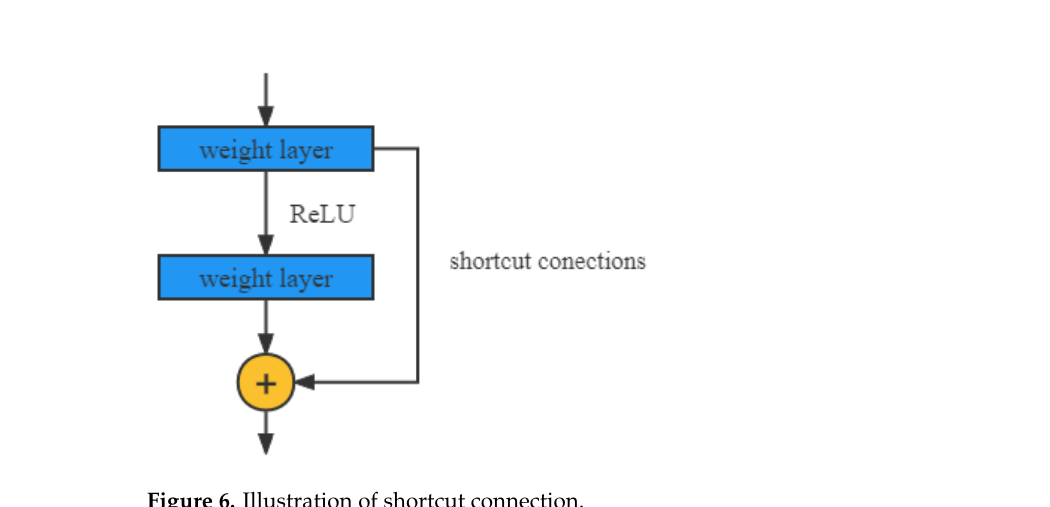
Figure 6. Illustration of shortcut connection.